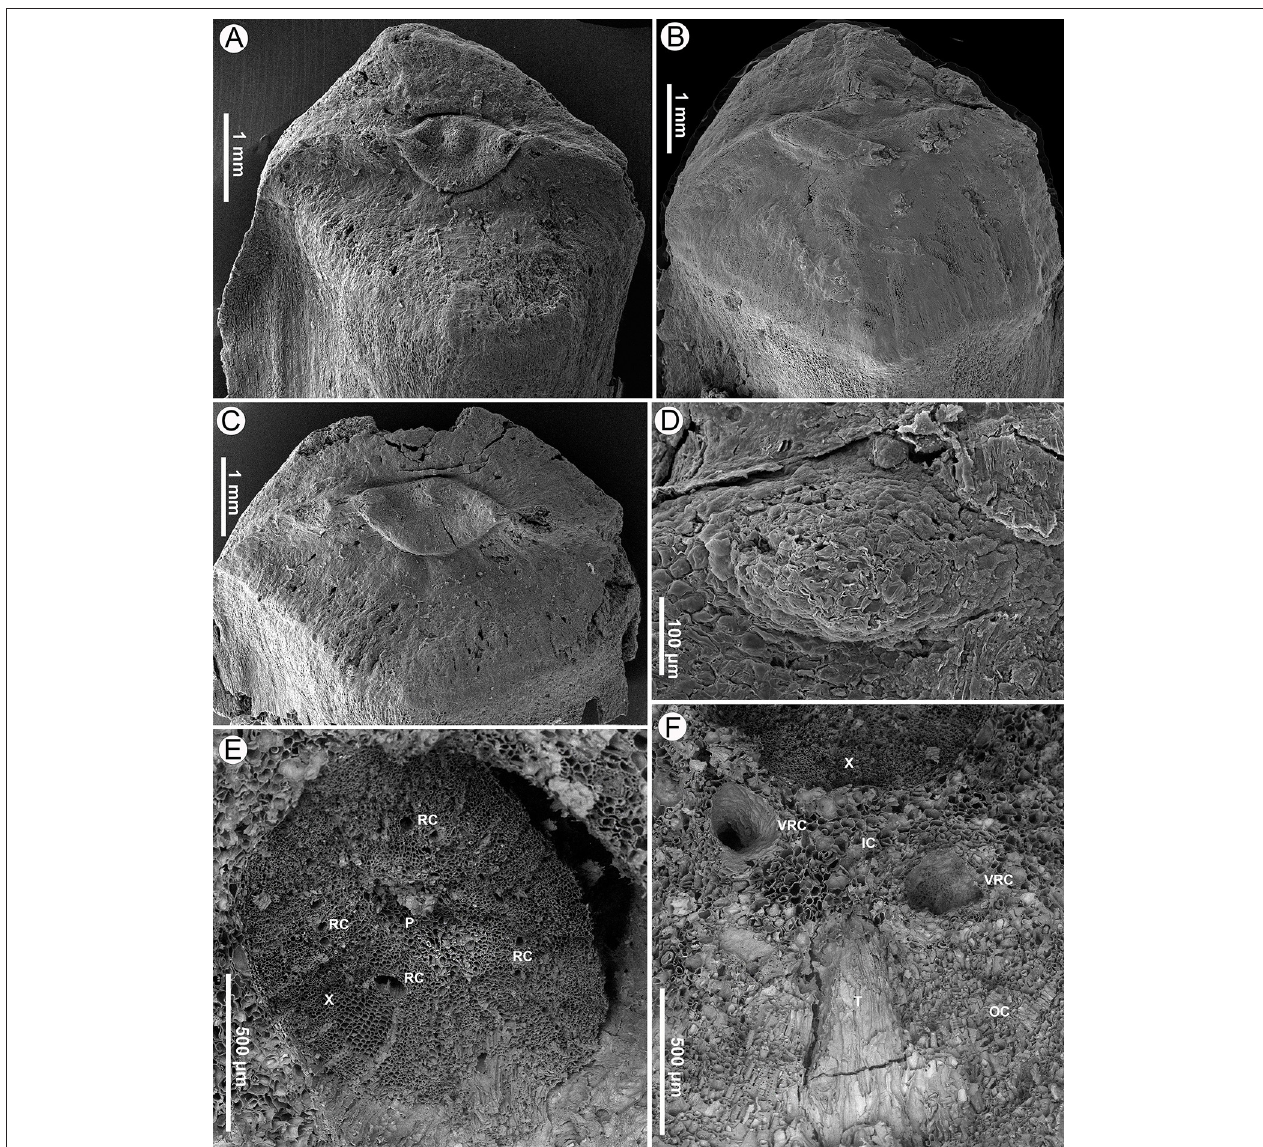
FIGURE 3 | Seed scales and transverse sections of a cone axis of Pinus prehwangshanensis sp. nov., specimen MMRH171, SEM. (A–C) Apophyses with perexcentromucronate umbo. (D) Mucro, an enlargement in (B) . (E) Transverse section of a cone axis showing a vascular cylinder (P – pith; X – xylem; RC – resin canals). (F) Transverse section of a cone axis cortex (X – xylem; IC – inner cortex; OC – outer cortex; T – trace of bract-scale vascular complex, VRC – vertical resin